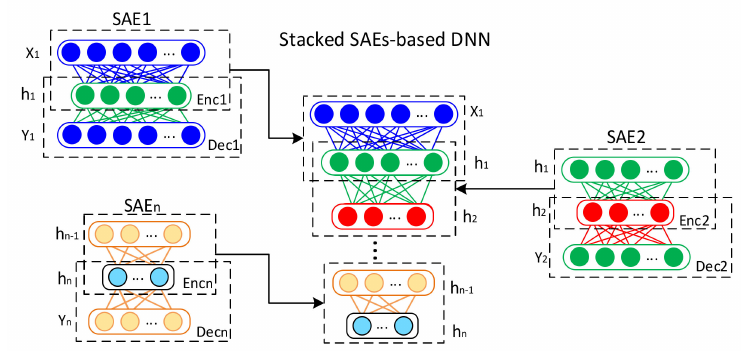
Figure 3. Schematic Deep Neural Network (DNN) construction and